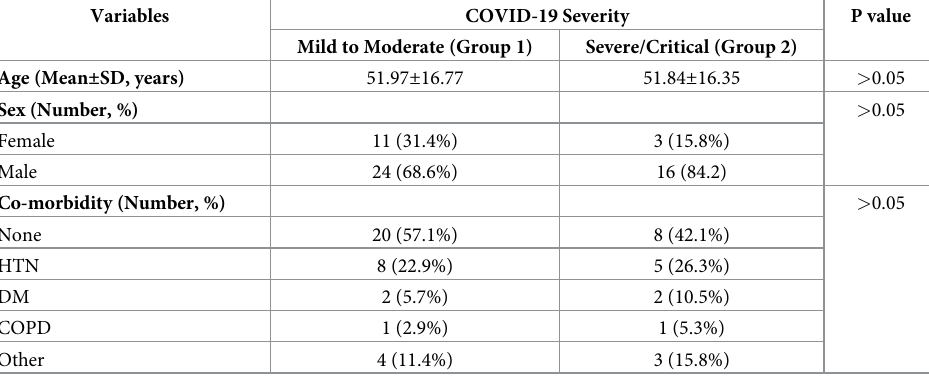
Table 1. Demographic and clinical data of the subjects.